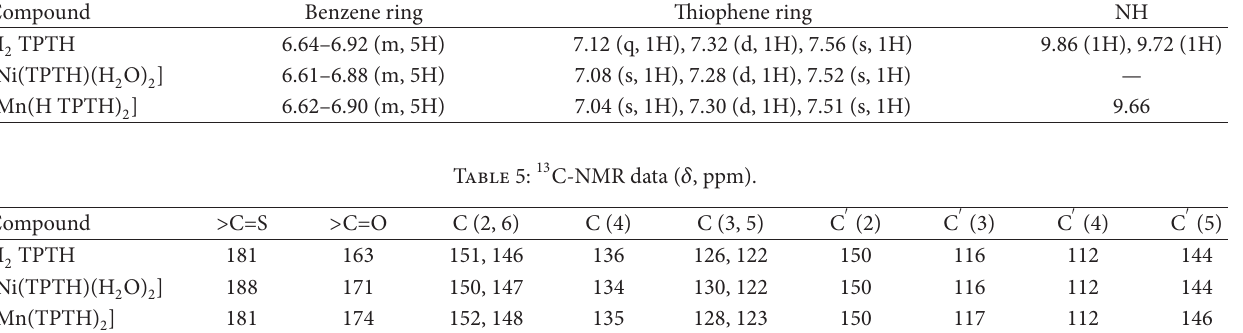
T 4: 1 H-NMR data of H